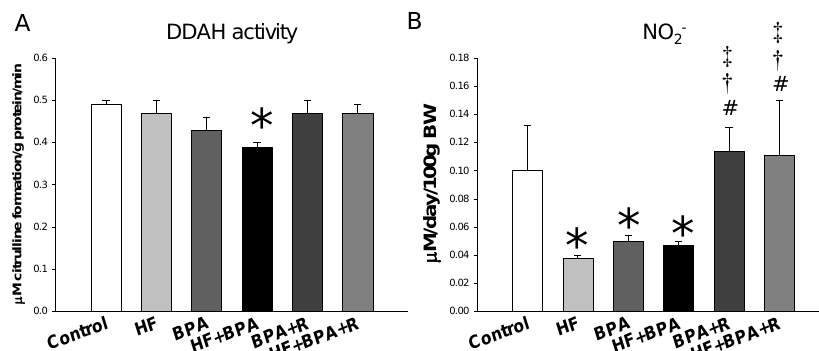
Figure 3. Effects of maternal high-fat diet (HF), bisphenol A (BPA), and resveratrol (R) on ( A ) renal DDAH activity and ( B ) urinary NO 2- levels in male offspring at 16 weeks of age. n = 7 – 8/group; * p < 0.05 versus control; # p < 0.05 versus HF; † p < 0.05 versus BPA; ‡ p < 0.05 versus HF + BPA.